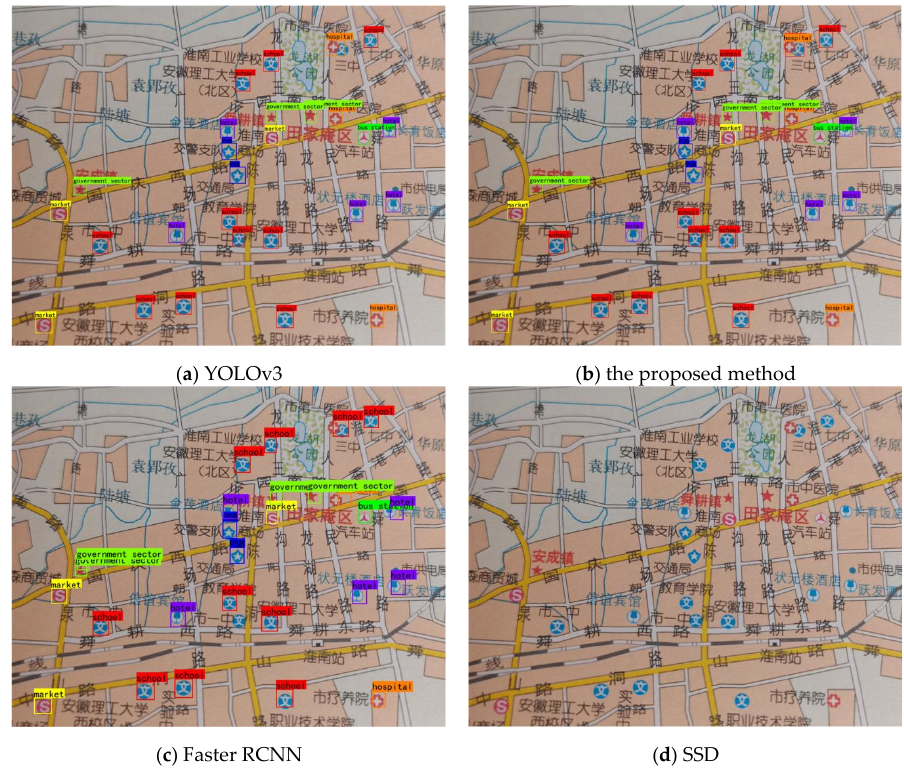
Figure 6. Point Symbols Recognition Results of Four Models on the Target Smaller Map: ( a – d ) are the recognition results of YOLOv3, the proposed method, Faster RCNN, and SSD on smaller target maps, respectively.